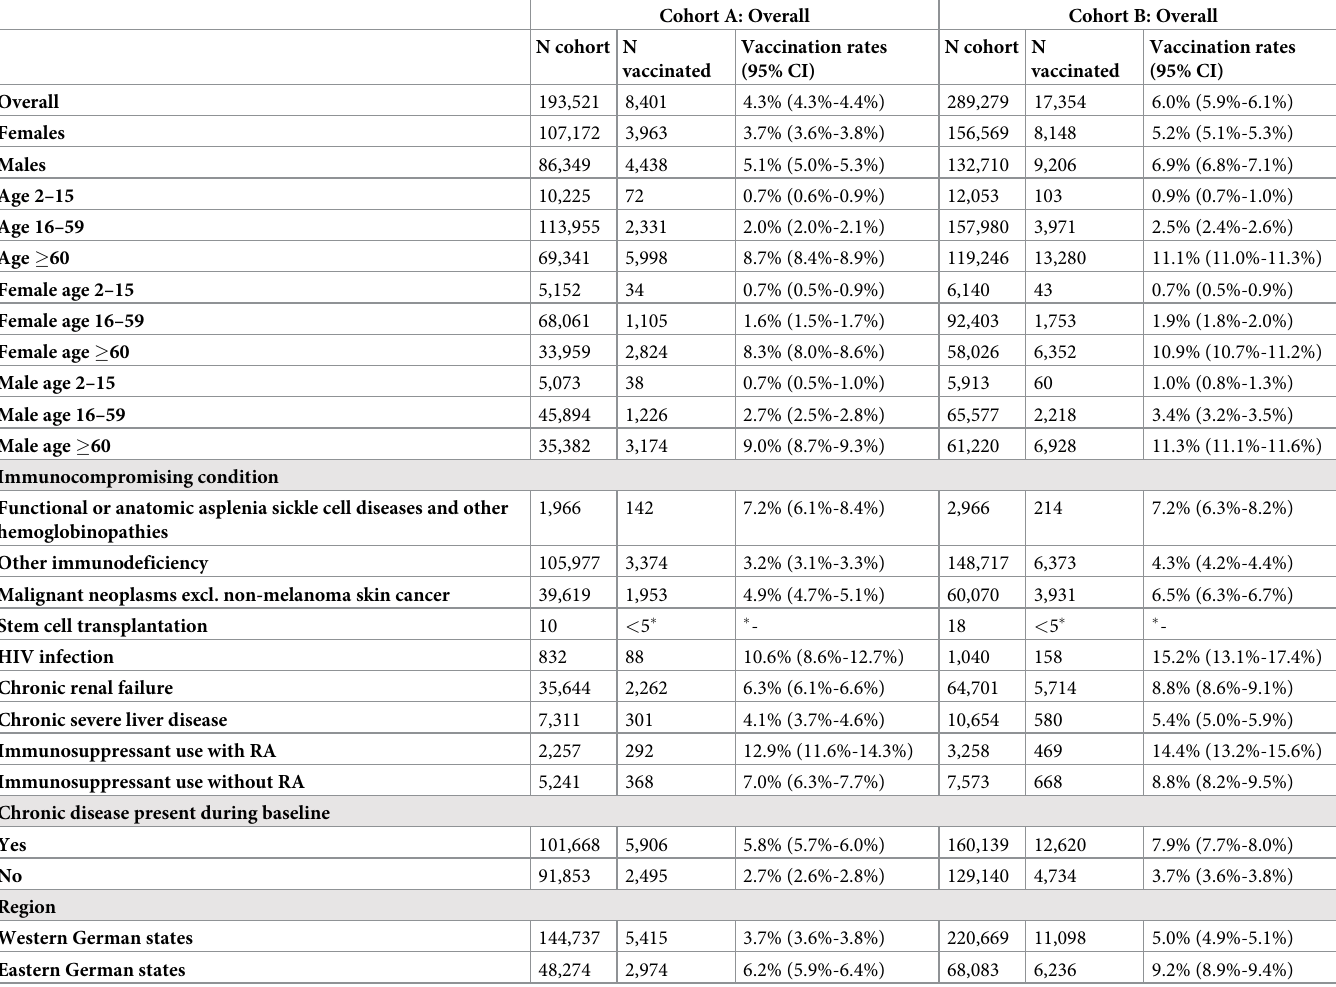
Table 3. Pneumococcal vaccination rates with 95% CI within two years following diagnosis of immunocompromised